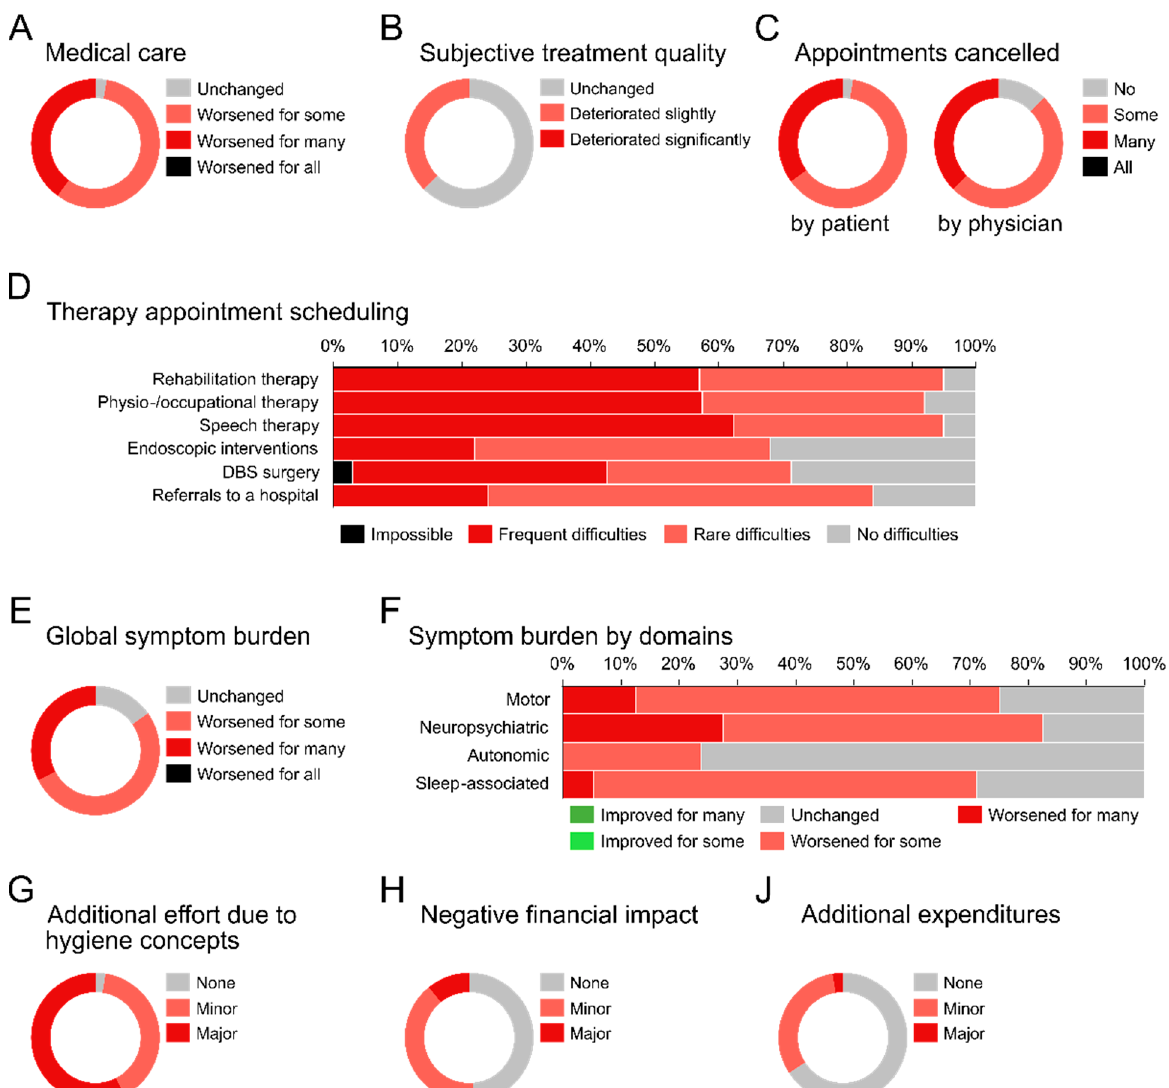
Figure 1. ( A ) Change in medical care quality compared to prepandemic period. ( B ) Change in subjective treatment quality compared to prepandemic period. ( C ) Cancellation of appointments by physician or patient. ( D ) Difficulties physicians faced in scheduling therapies for PD patients. DBS, deep brain stimulation. ( E ) Change in the overall symptom burden. ( F ) Change in motor and non-motor symptoms observed by study participants. ( G ) The implementation of hygiene concepts required additional effort from physicians. ( H ) Financial impact physicians faced since pandemic onset. ( J ) Additional expenditures for physicians during the pandemic.